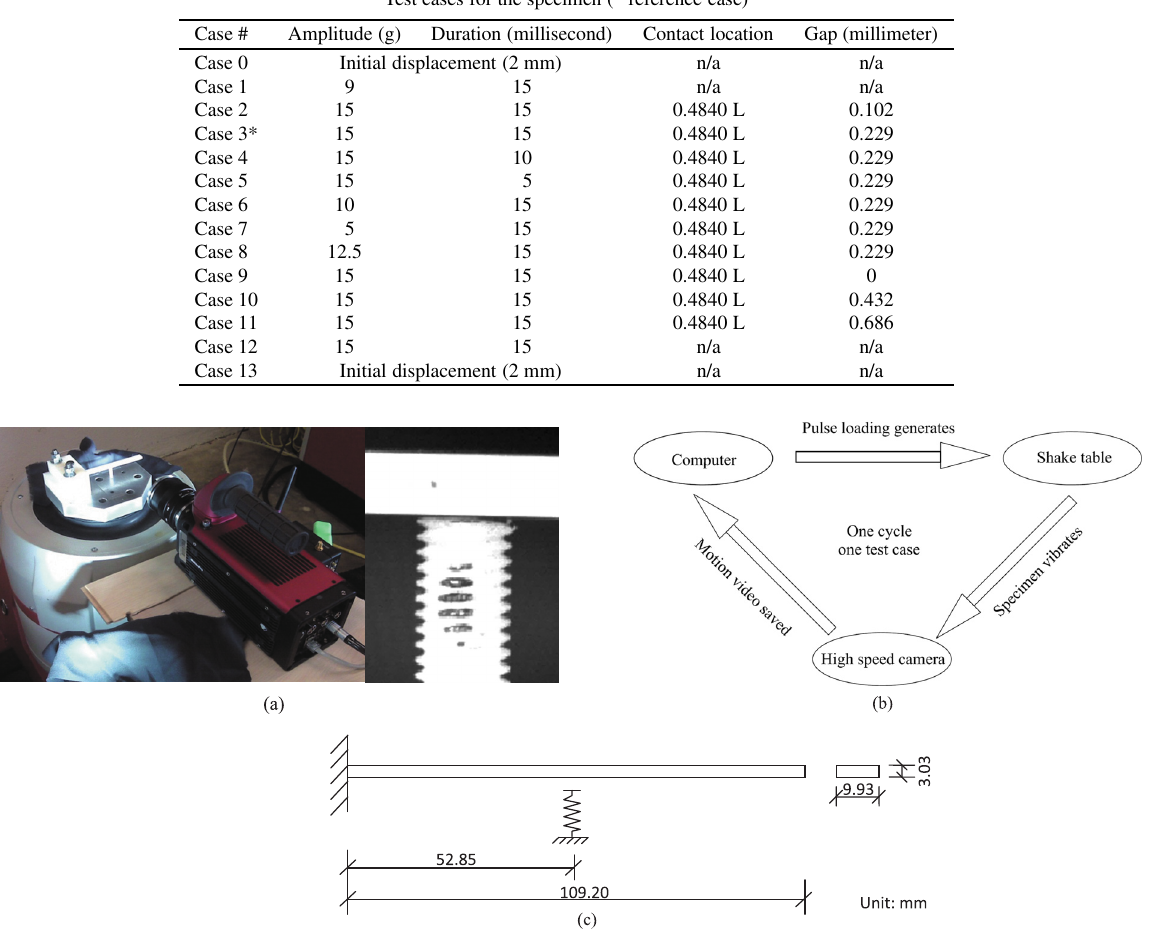
Table 1 Test cases for the specimen (* reference case)